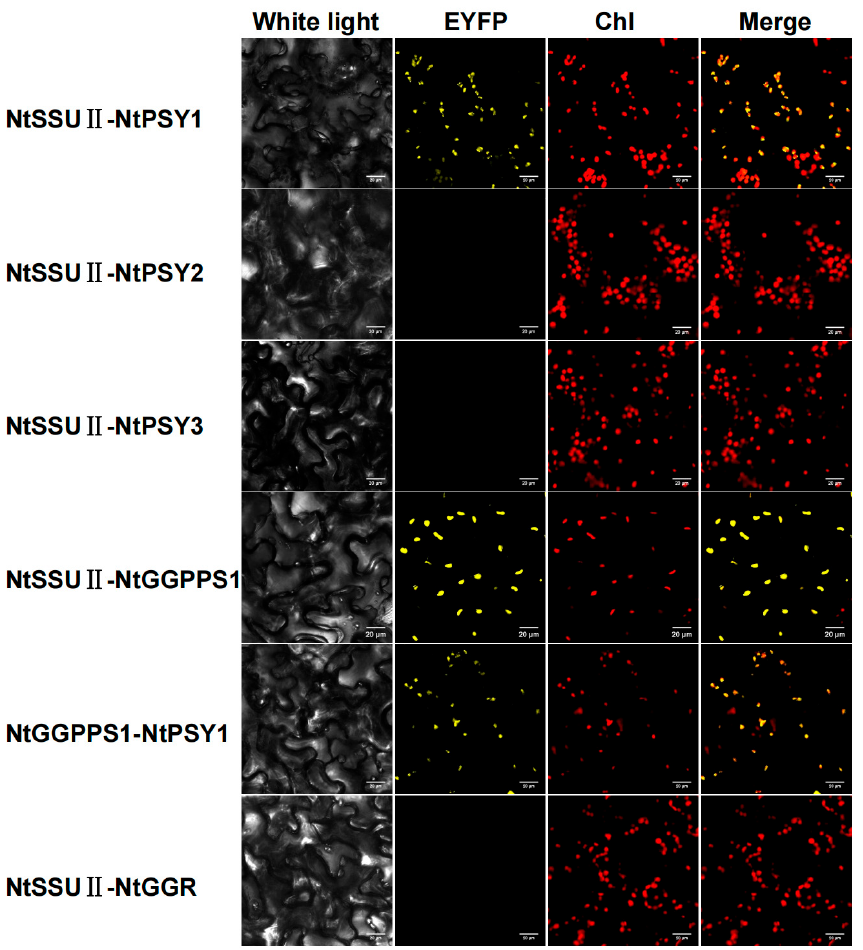
Figure 5. BiFC detection of interactions between NtSSU Ⅱ proteins and potential partners down- stream of the GGPP node. Chl, chlorophyll autofluorescence. Fluorescence of reconstructed EYFP was detected as the result of protein-protein interactions in the chloroplast (Chl).